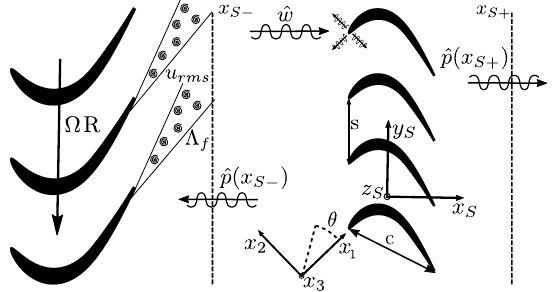
Figure 1. General Scheme of rotor-stator interaction broadband